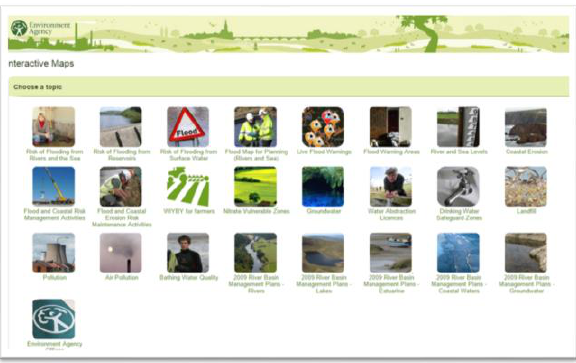
Figure 13: Another example of Integrated system, data/stakeholders/community contributing the spatial